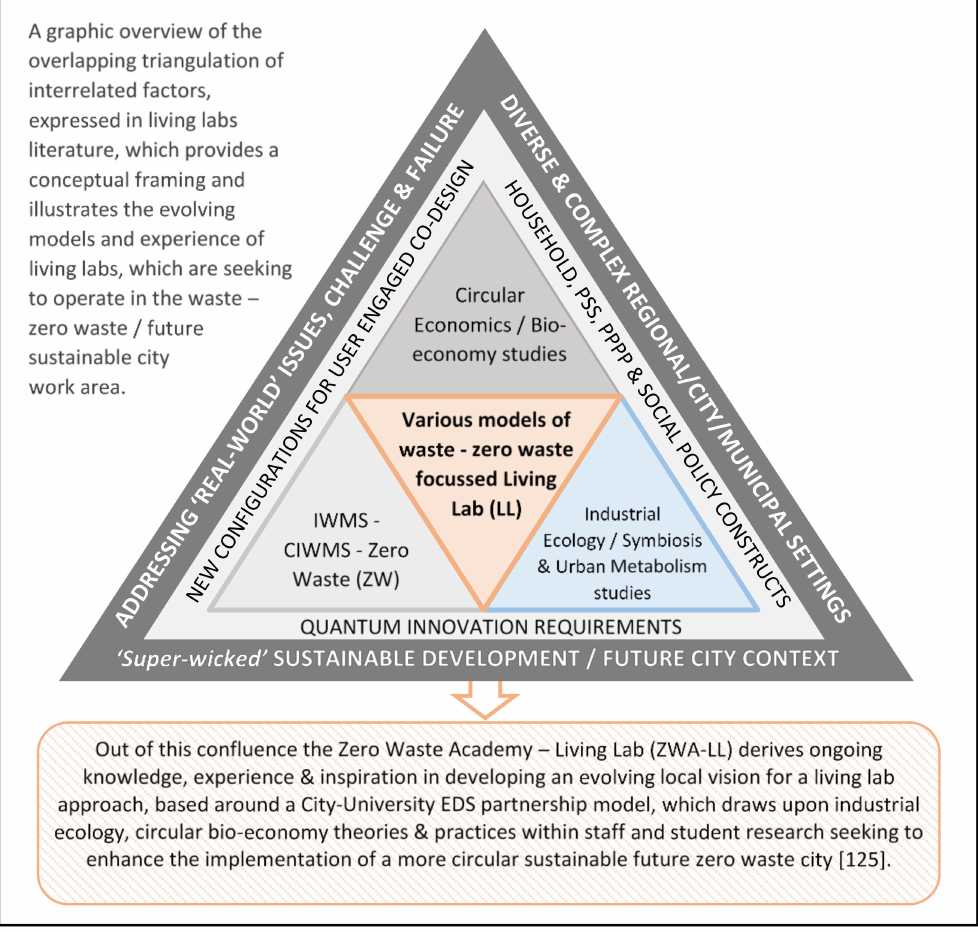
Figure 1. A graphic overview of the living lab—industrial ecology/urban metabolism—circular bio-economy—zero waste, synergy model, which underpins the past and proposed future development model of the New Zealand based, Zero Waste Academy (ZWA-LL)